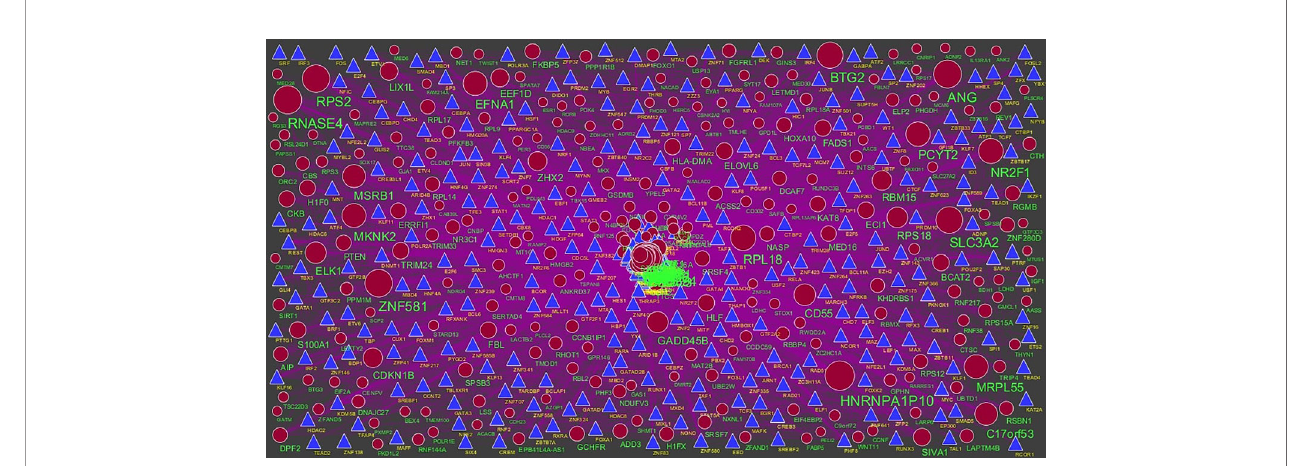
FIGURE 10 | TF ‐ gene network of predicted target down regulated genes. (Blue triangle - TFs and red circles- target up regulated genes).